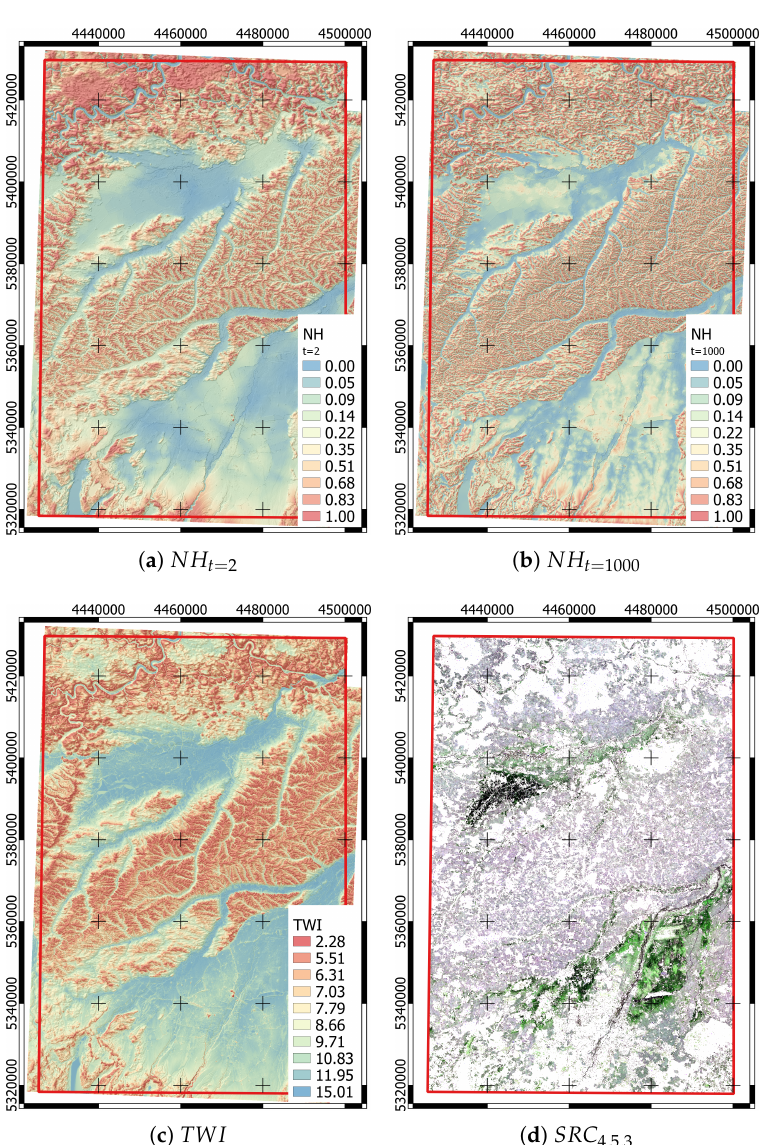
Figure 4. Visualization of multi-scale ( a , b ) and one-dimensional terrain attributes ( c ); cf., Table 1) as well as of selected SRC bands ( d ). Projection: EPSG 31468 (https://spatialreference.org/ref/epsg/31 468; accessed on 13 March